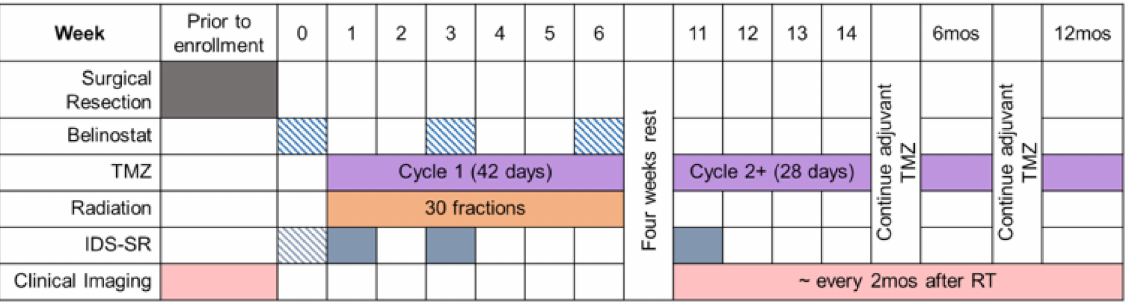
Figure 1. One-year timeline of chemotherapy, intravenous belinostat, and radiation for patients in